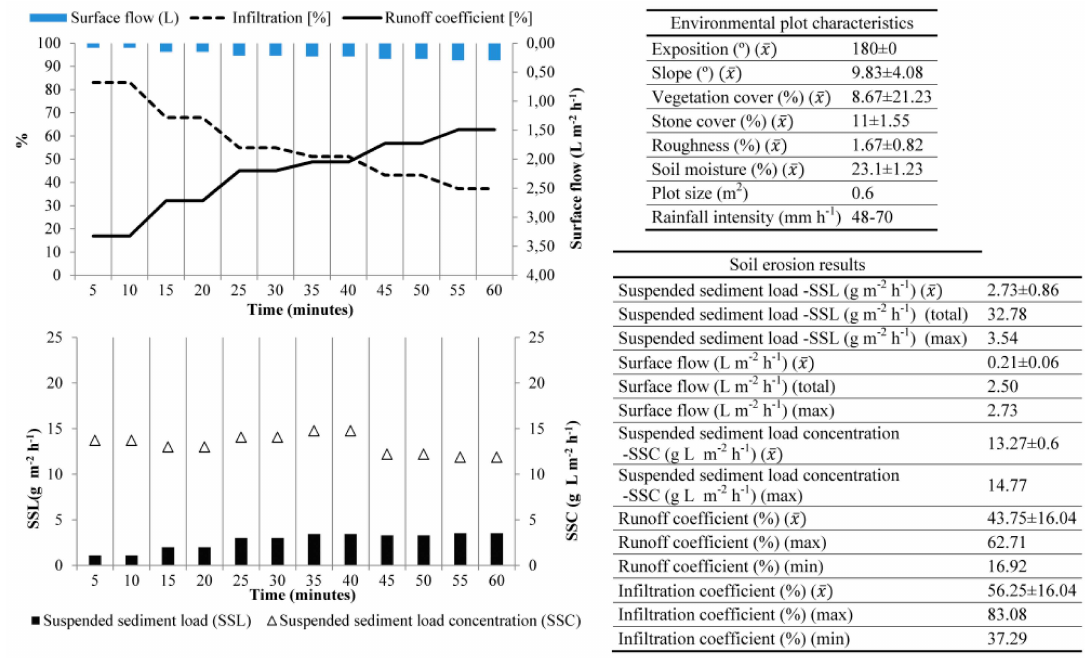
Figure 5. Rainfall simulations in Els Hostalest de Pierola (Penedès,